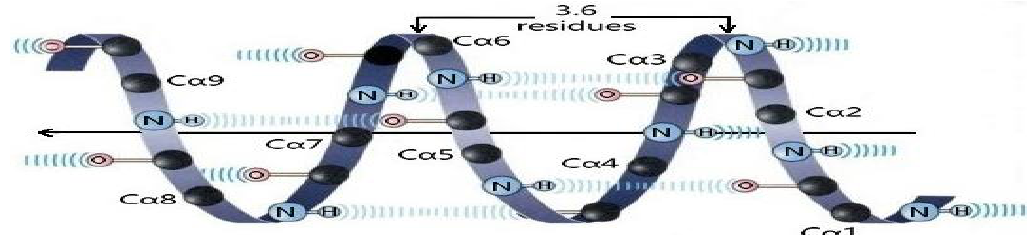
Figure 2. The standard helical conformation of 3.6 13 helix.